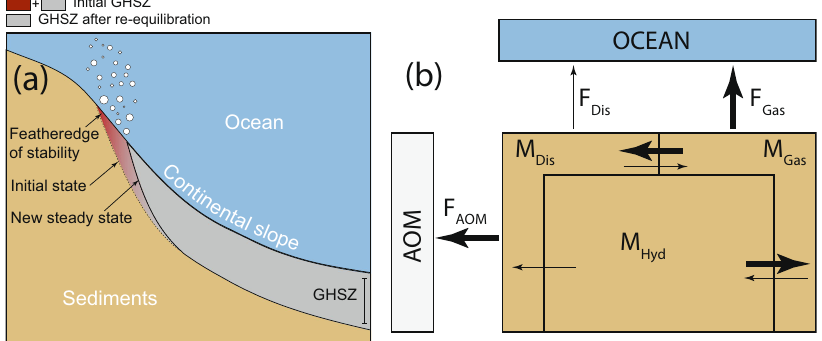
Fig. 1 Schematic view of a shelf slope hydrate system and of the methane (CH 4 ) transport pathways. a Cartoon of the continental slope and the gas hydrate stability zone (GHSZ) before and after re-equilibration to a warming perturbation of the bottom water. b A schematic overview of the three CH 4 mass pools within the sediments and the general direction of the CH 4 mass transport during hydrate dissociation, within and out of the system, illustrated by the thick arrows (minor pathways are indicated by thin